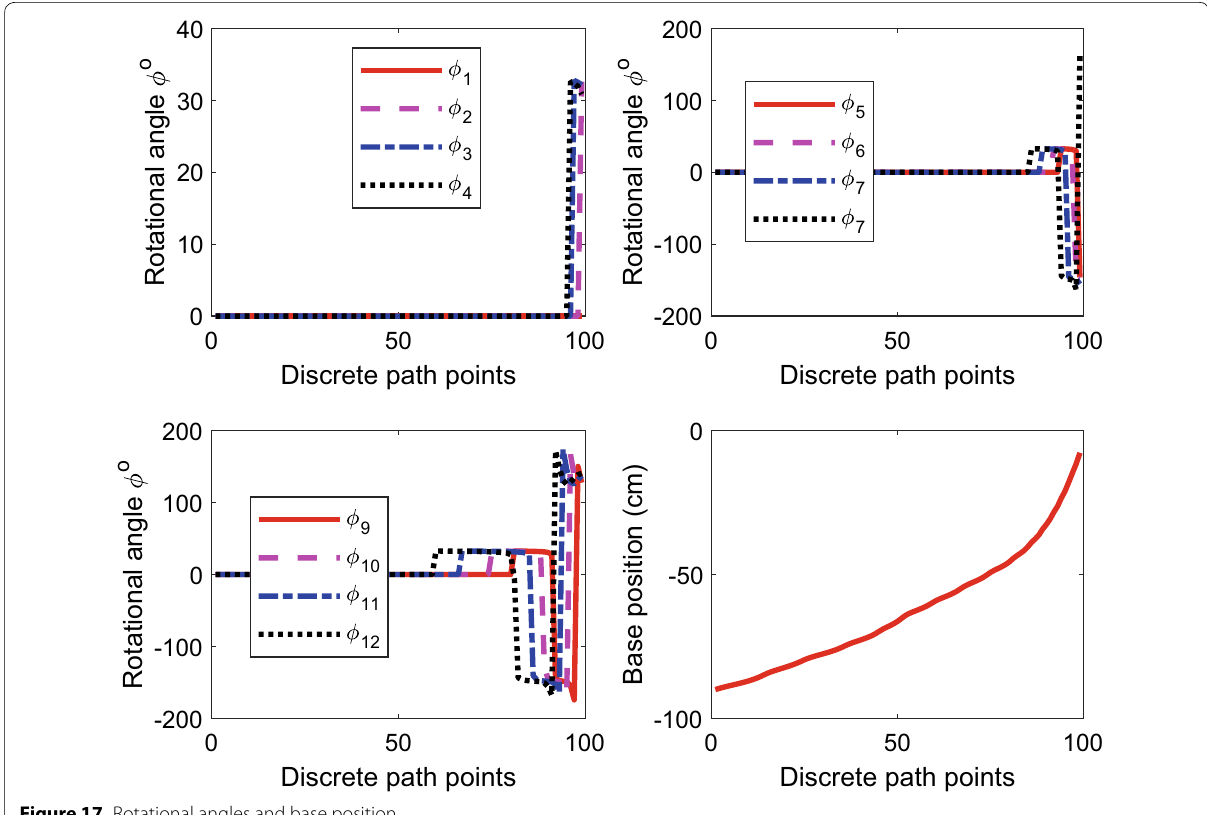
Figure 17 Rotational angles and base